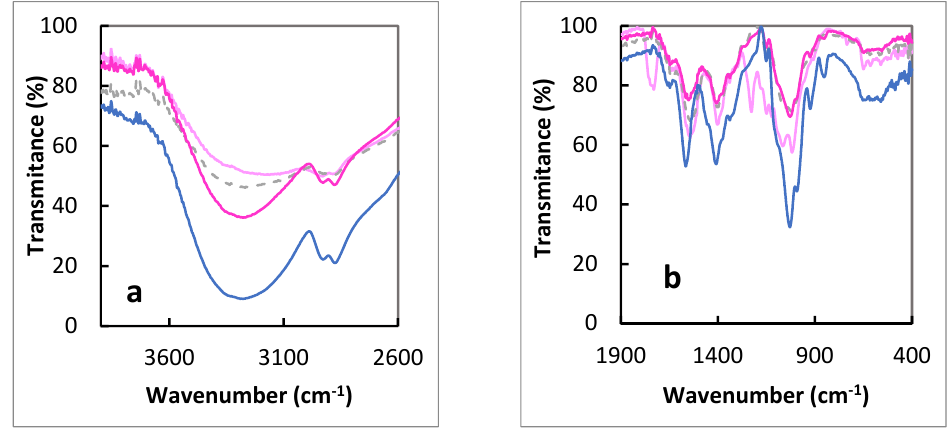
Figure 2. The ATR IR spectra of polymeric film: CS (dashed line), CS/ Gly (blue line), CS/Rh B (dark pink line), and CS/NPs (light pink line) in the region ( a ) 3700 − 2600 cm − 1 and ( b ) 1900 − 400 cm − 1 .